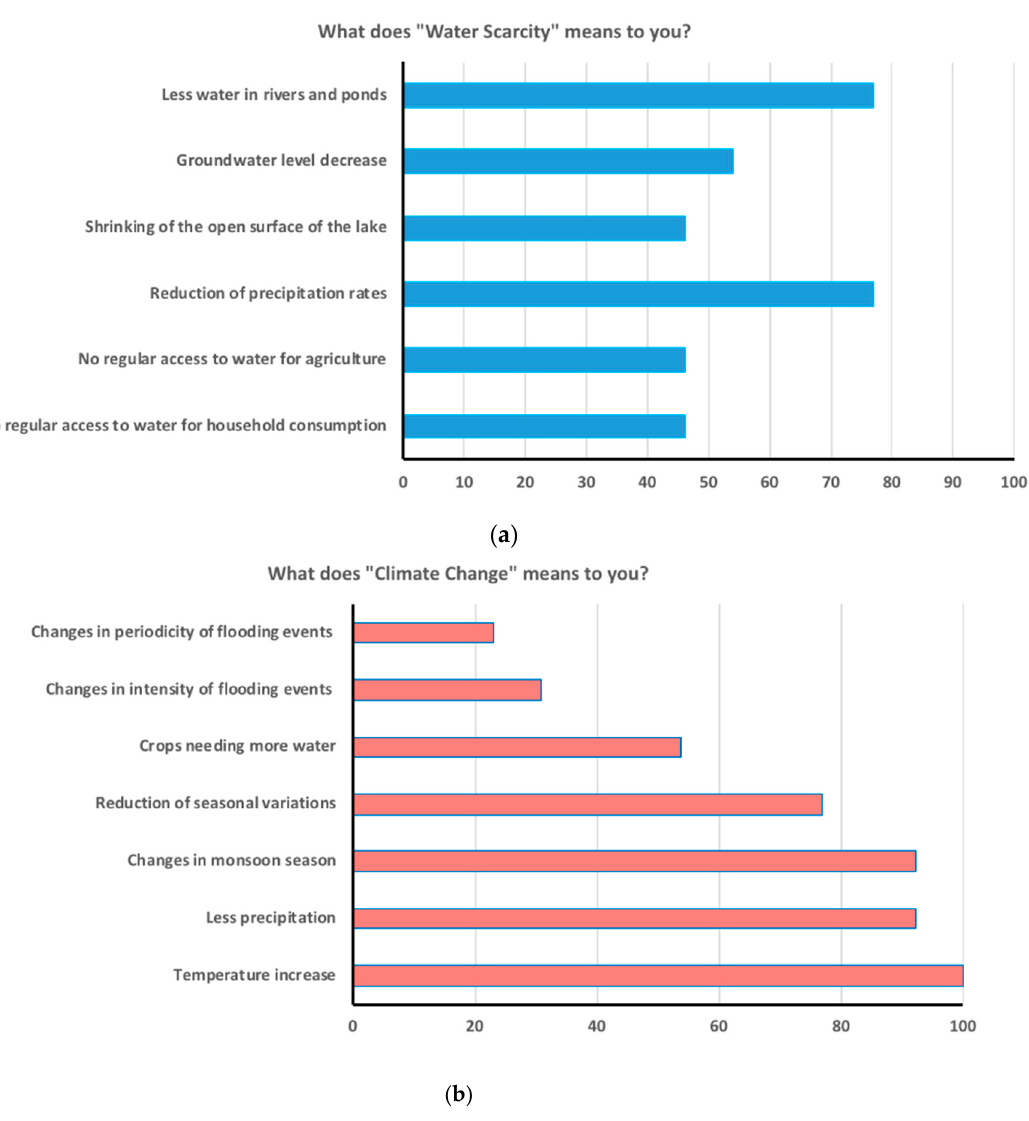
Figure 8. Perception of ( a ) water scarcity and ( b ) climate change issues by the well owners involved in the monitoring network.